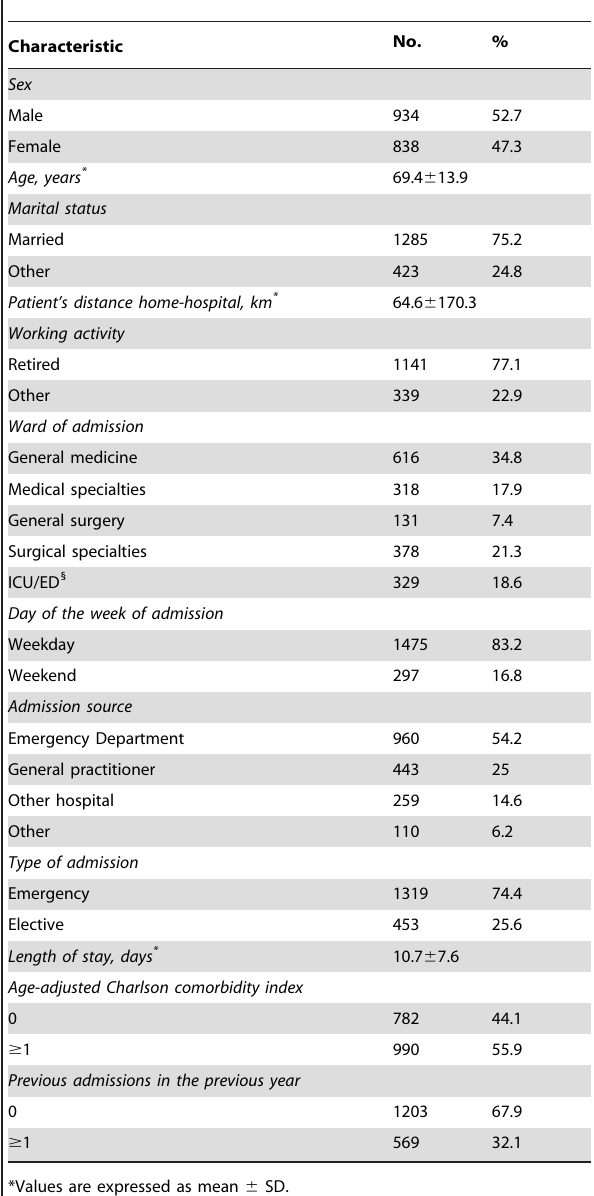
negative relationship with adherence to AMI ( b = 2 0.19, p- value =0.04) (data not shown).